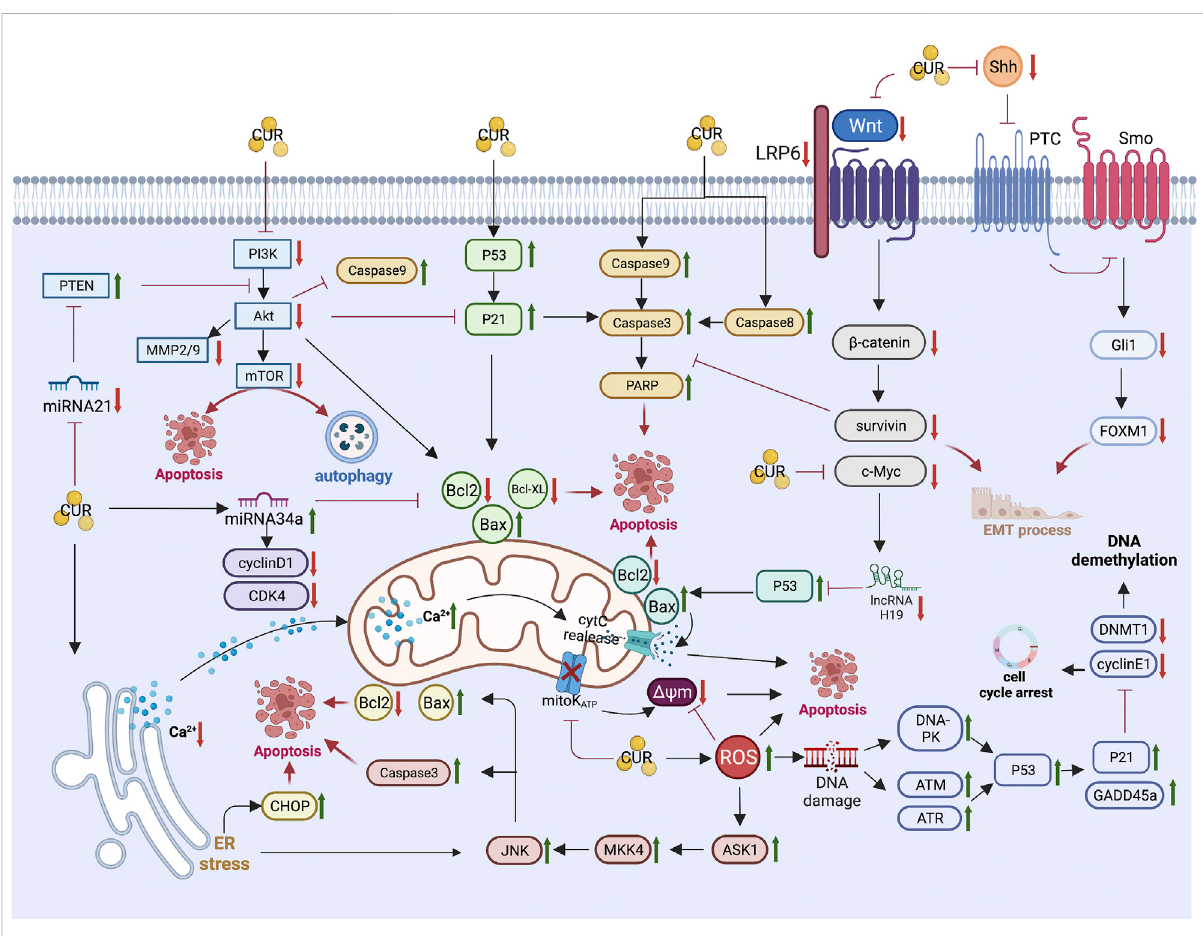
FIGURE 2 Pharmacological mechanism underlying theeffects of curcumin on gastric cancer (Created with Biorender.com). PI3K, Phosphatidylinositol 3- kinase; Akt, Protein kinase B; mTOR, mammalian target of rapamycin; MMP2/9, matrix metalloproteinase 2/9; PTEN, phosphatase and tensin homolog; CDK4, cyclin-dependent kinase 4; Bcl2,B-cell lymphoma 2; Bax, B-cell lymphoma-2 (Bcl-2)-associated X protein; PARP, Poly (ADP- ribose) polymerase; LRP6, lipoprotein receptor-related protein 6; Shh, sonic hedgehog; Gli1, Glioma-associated oncogene homologue 1; FoxM1, forkhead box transcription factor M1; EMT, epithelial-mesenchymal transition; cytC, cytochrome C; Δψ m, mitochondrial membrane potential; ER, endoplasmic reticulum; CHOP, CCAAT/enhancer binding protein homologous protein; JNK, c-Jun N-terminal kinases; MKK4, mitogen-activated protein kinase kinase 4; ASK1, apoptosis signal-regulated kinase 1; ROS, reactive oxygen species; DNA-PK, DNA-dependent protein kinase; ATM, Ataxia-telangiectasia mutated; ATR, ataxia telangiectasia and Rad3-related; GADD45a, growth arrest and DNA damage- inducible protein GADD45 alpha; DNMT1, DNA methyltransferase